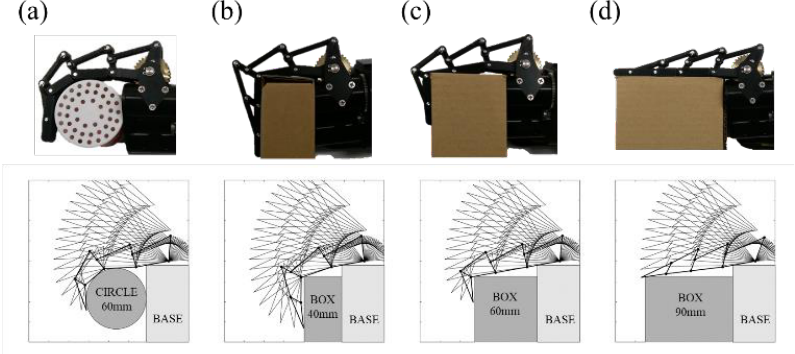
Figure 16. Adaptive feature when grasping different objects: ( a ) 60 mm cylindrical object, ( b ) 40 mm box, ( c ) 60 mm box, and ( d ) 90 mm box.